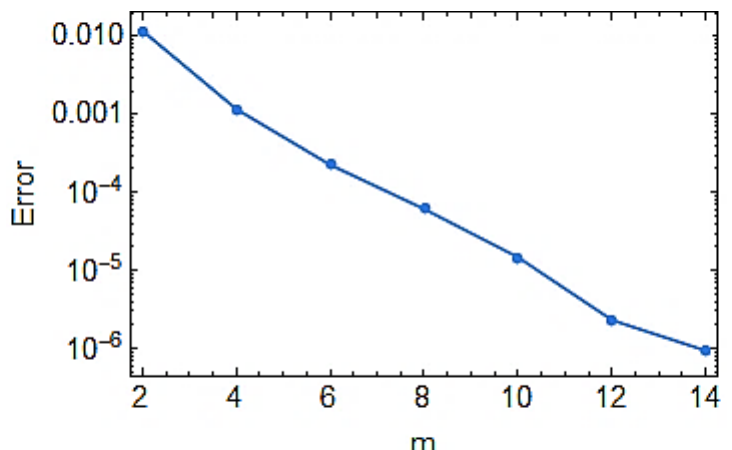
Figure 17. Assessment of HAM and numerical method for φ ( ξ ) .